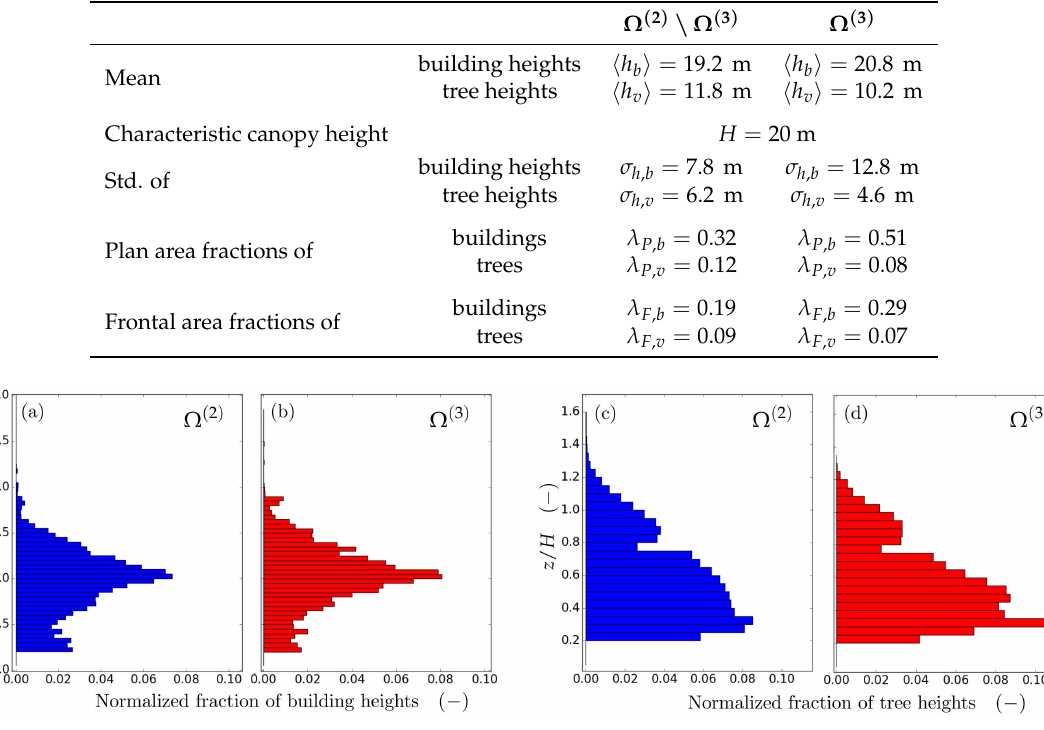
Figure 2. Normalized distributions of ( a , b ) building and ( c , d ) tree heights within Ω ( 2,1 ) and Ω ( 3,2 ) domains